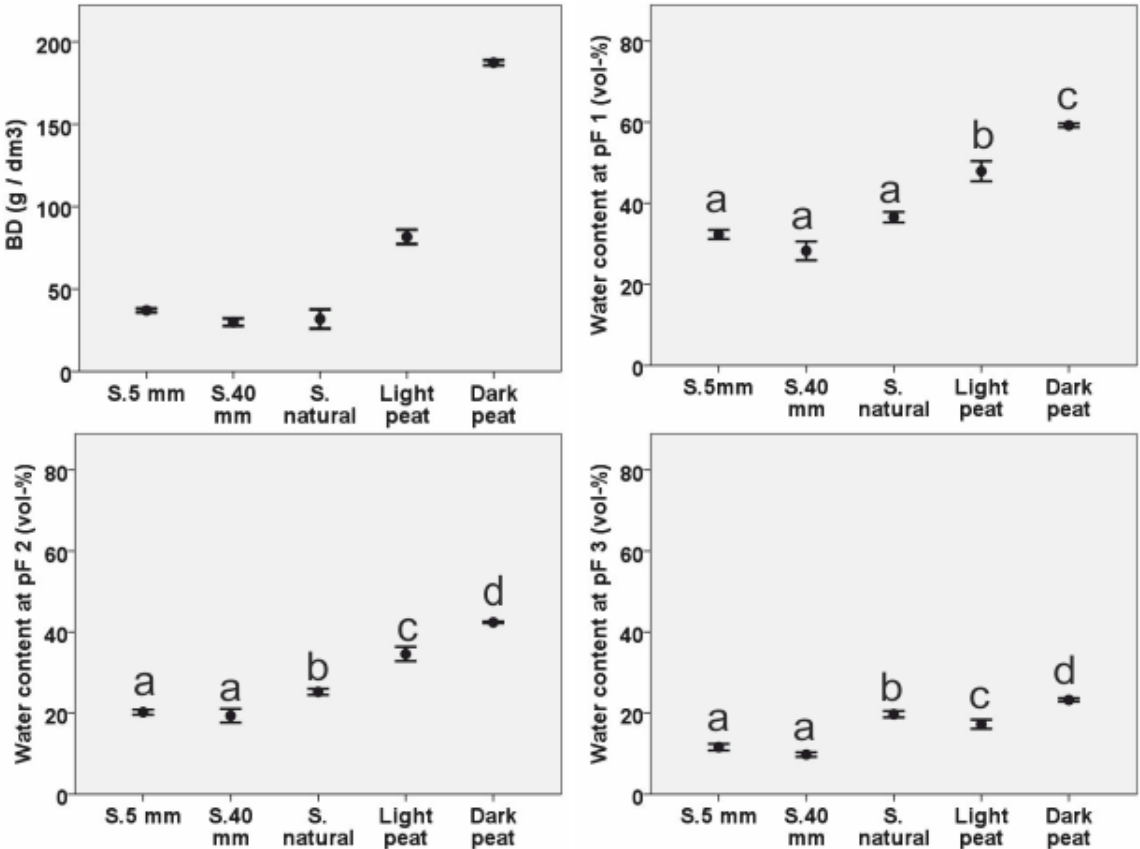
Figure 5. Bulk densities ( BD ) and volumetric water retention of experimental materials under differing matric potentials (pF1, pF2 and pF3). Means ± standard deviation (SD) are presented (n = 3). A different letter above the data point indicates a significant difference (p < 0.05). ‘S.’ on the x-axis denotes Sphagnum moss.